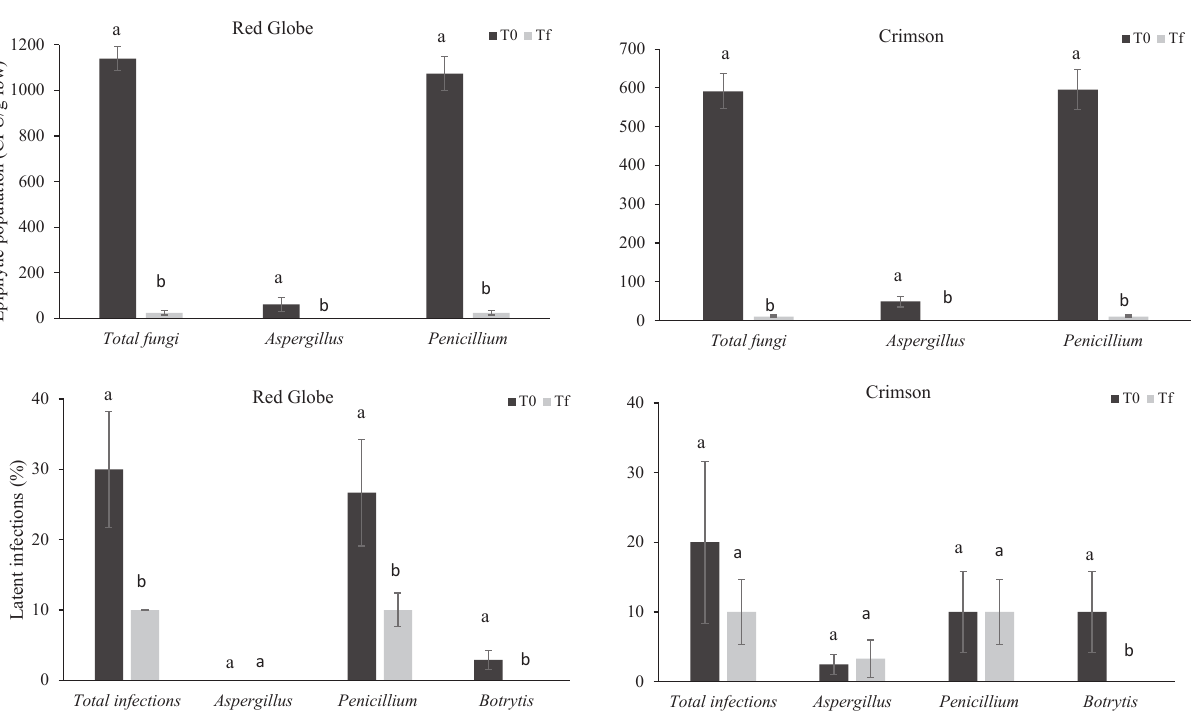
Figure 1. Mean populations of epihytic fungi, and proportions (%) of latent fungal infections, on ‘Red Globe’ and ‘Crimson’ table grapes, stored with SO 2 generating pads. For each variable, mean values at T 0 (black histogram, beginning of storage) and T f (end of storage) accompanied by different letters are significantly different ( P ≤ 0.05). Bars represent standard errors of means, each from three